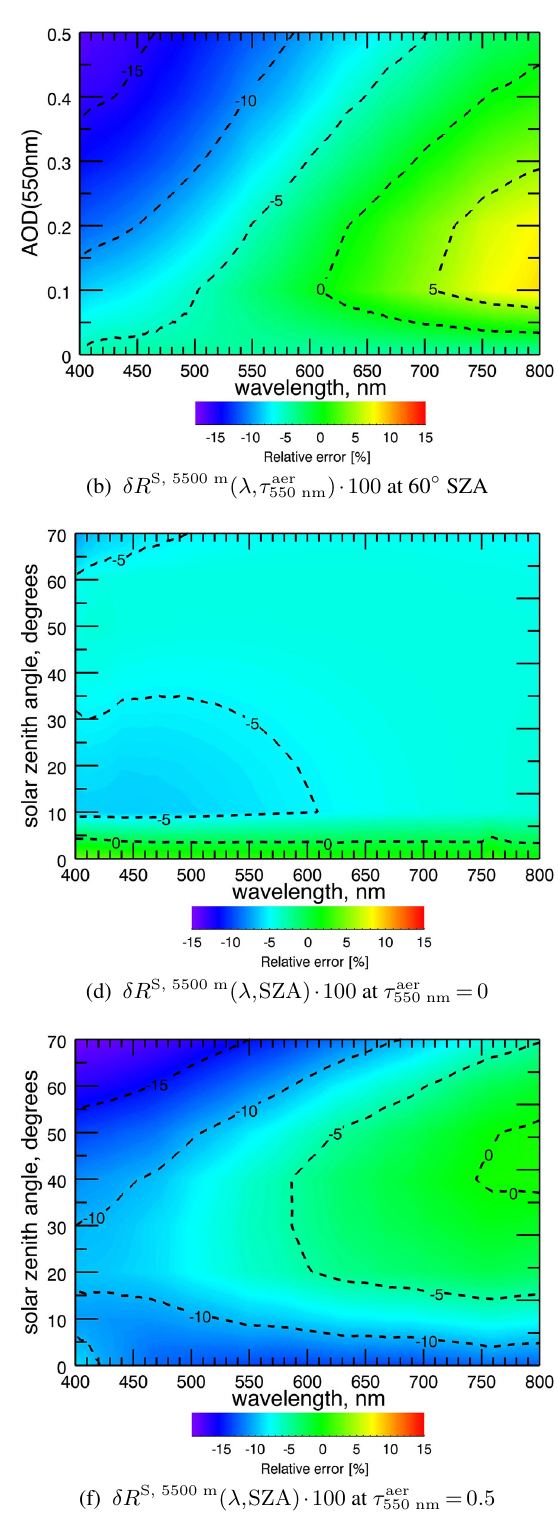
Fig. 8: Overall accuracy with a sensor at 5500 m. Fig. 8. Overall accuracy with a sensor at 5500